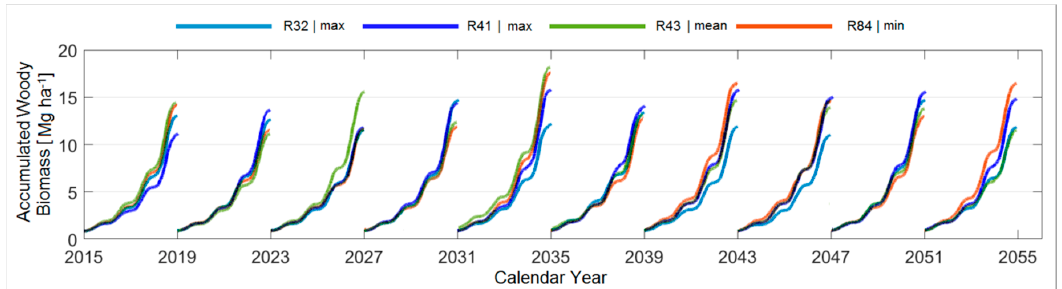
Figure A2. Projected accumulated woody biomass of black locust trees under realisations that rendered minimum (R84, orange), mean (R43, light green), and maximum (R41, dark blue; R32, light blue) average temperature values during the vegetation period from 2015 to the end of 2054.